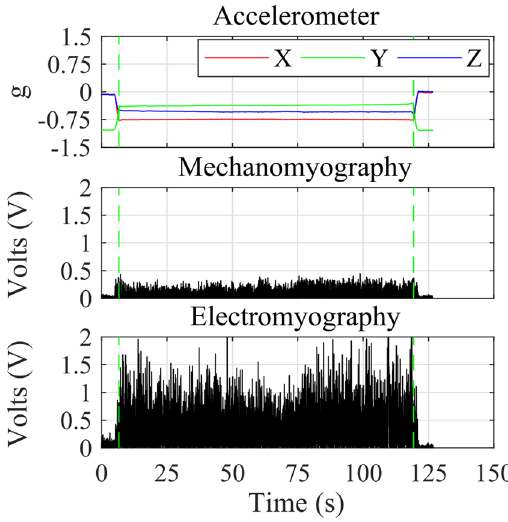
Figure 7. Example of muscle phase segmentation using accelerometer data from stage two of the exertion trial (figure showing data from participant 5, during exertion/stage two). Start and stop points were segmented for the held portion of the wall squat (green dashed